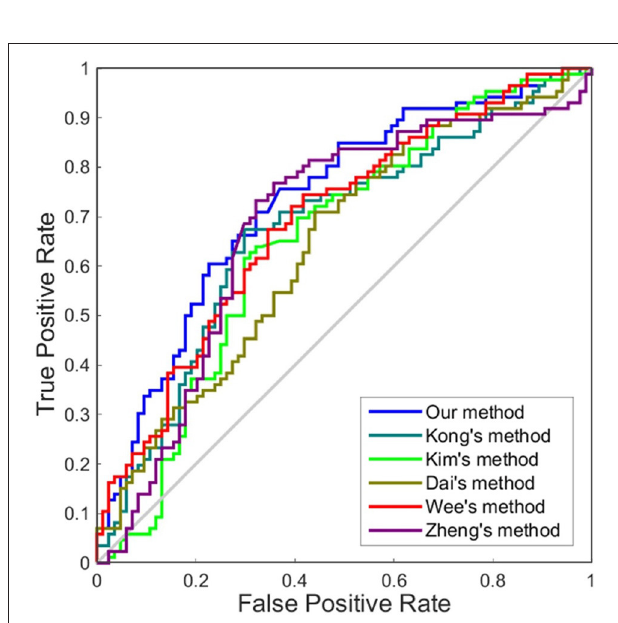
FIGURE 5 | ROC curves of different methods using one dimension to distinguish sMCI and pMCI. The different line colors represent different methods to construct individual morphological brain networks based on cortical thickness. ROC, receiver operating characteristic.